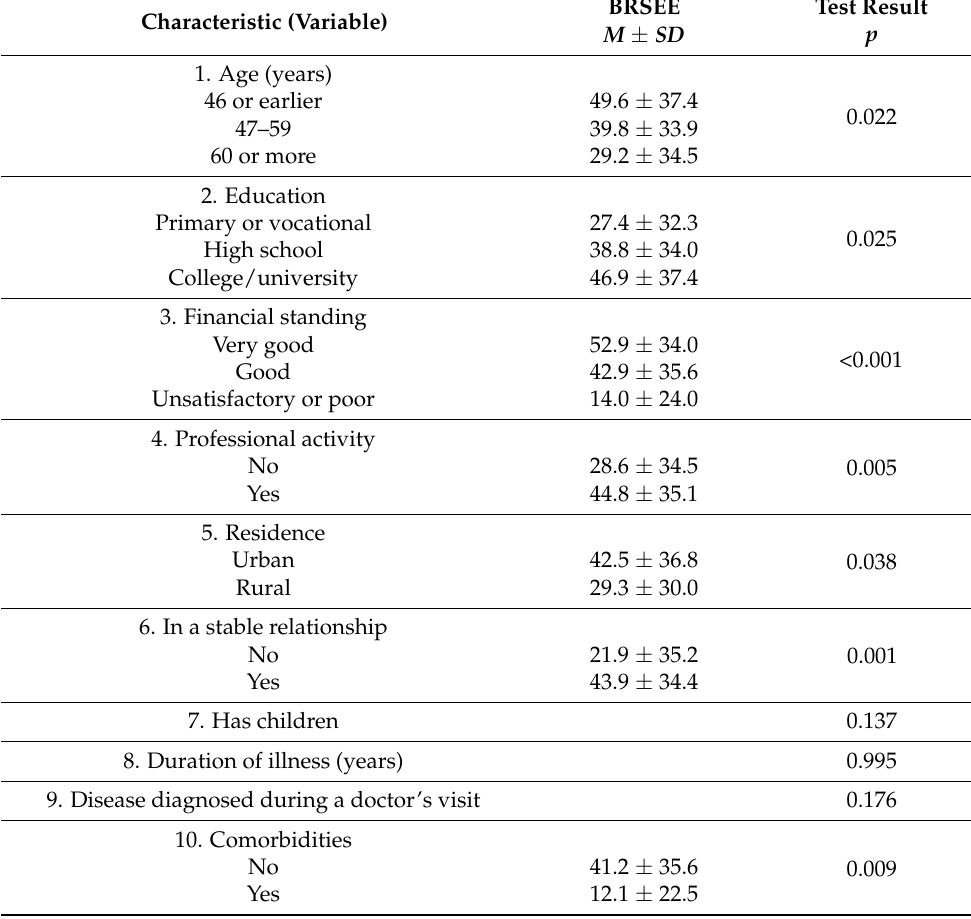
Table 3. Sexual enjoyment (EORTC QLQ-BR23 BRSEE domain) in patients differing in terms of selected socio-demographic and clinical characteristics, with test